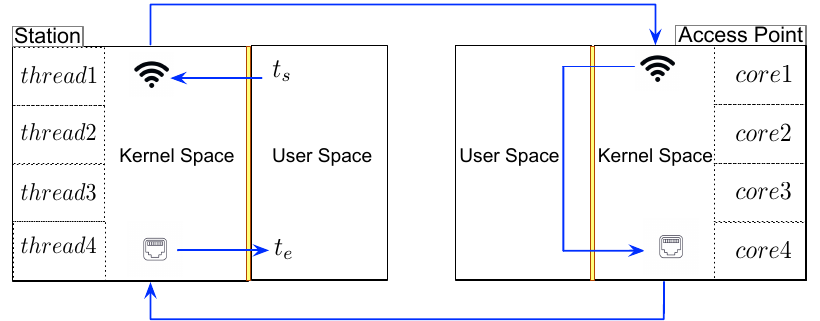
Figure 8. The closed-loop testbed used to determine f c and f sc . At the time t s , a packet is originated from the station and is sent to the AP. Once this packet is received, a new packet is created on the AP and sent to the station, completing a closed loop at time t e